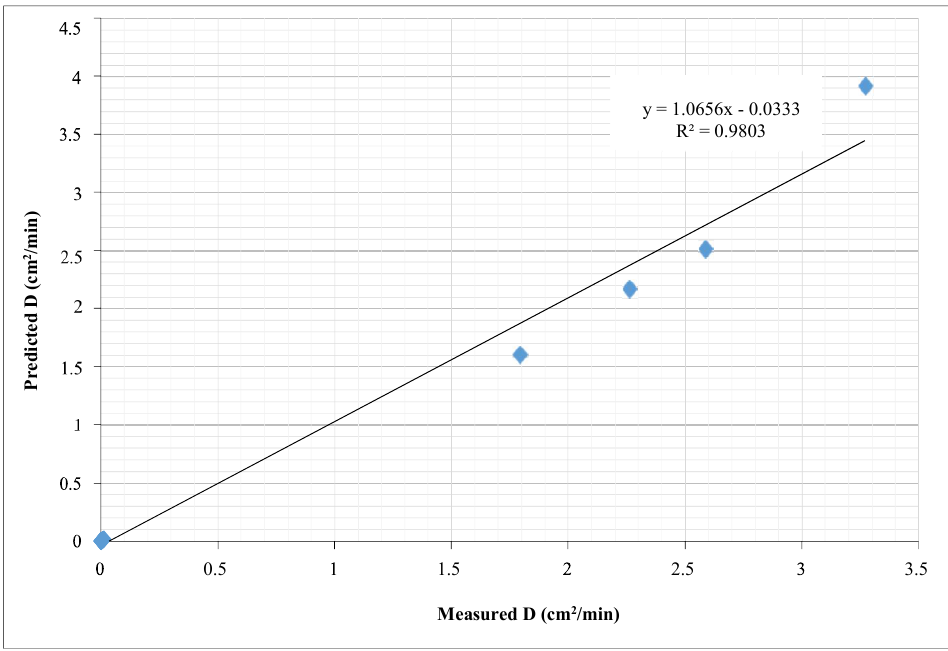
Figure 2. Calibration graph showing predicted and measured of dispersion in the